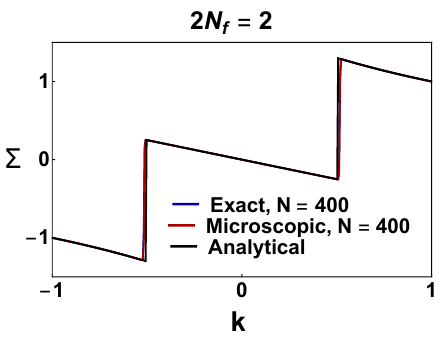
Figure 11 . The k dependence of the condensate in the limit of zero quark masses. The exact result (blue curve) and microscopic result (red curve) have been obtained from the partition func- tions (2.52) and (A.18) , for N = 400 and m 1 = m 2 = 10 (cid:0) 4 , respectively. Note that the two curves completely overlap. The black curve represents the analytical result (3.51)